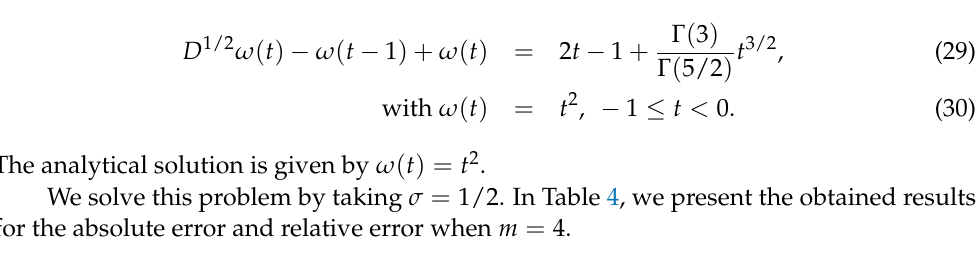
Table 4. Absolute error and relative error results for Example 3 with m = 4, σ =